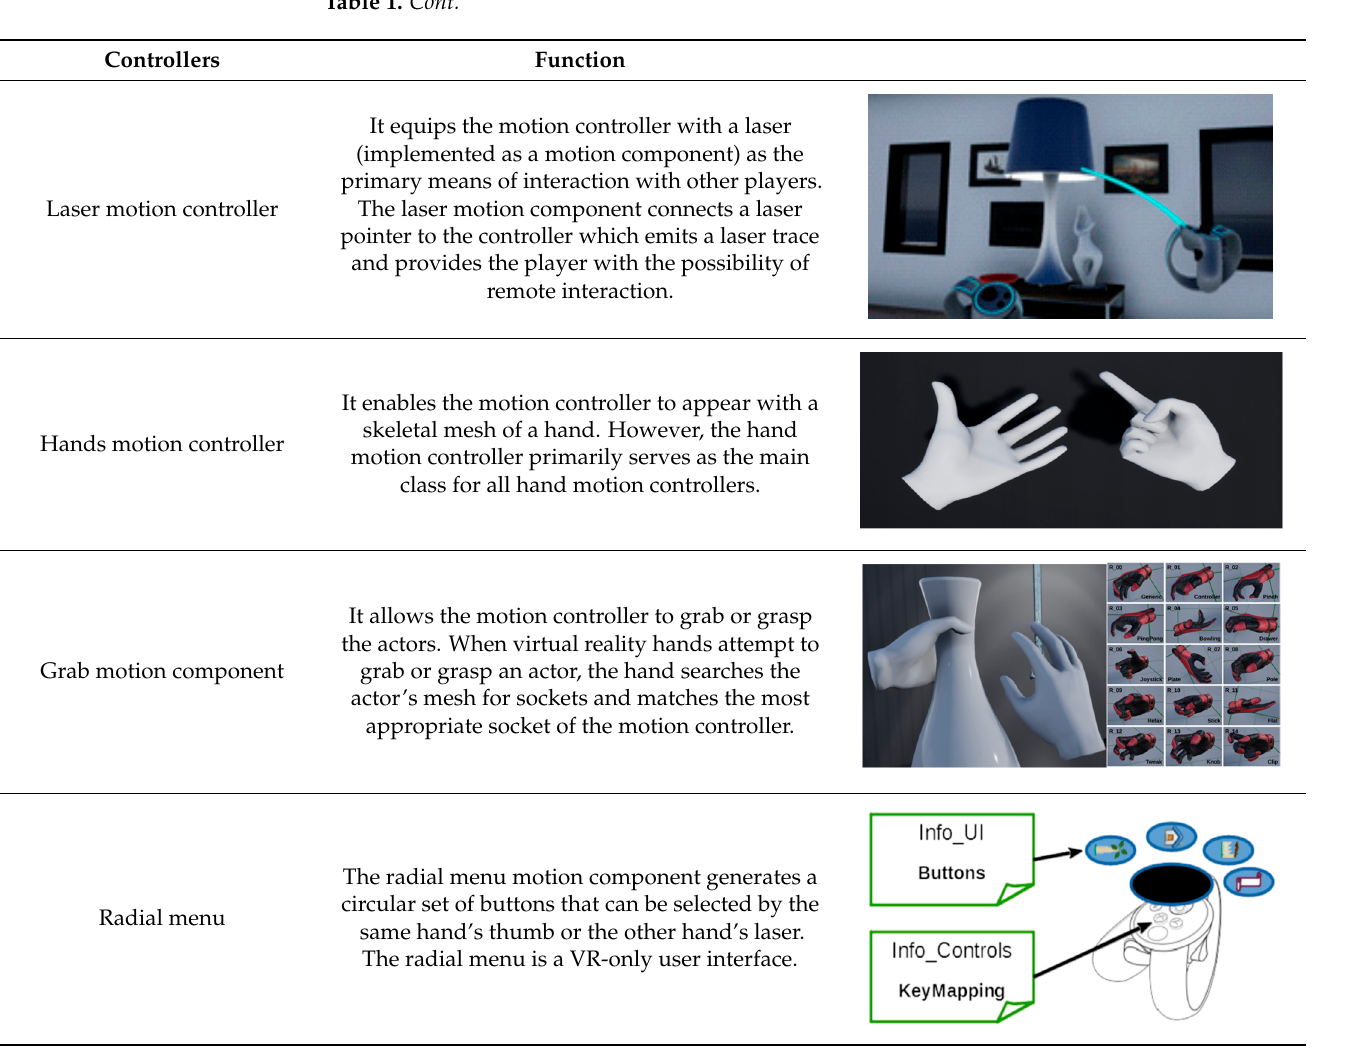
Table 1. Controller styles with functionalities. Controllers